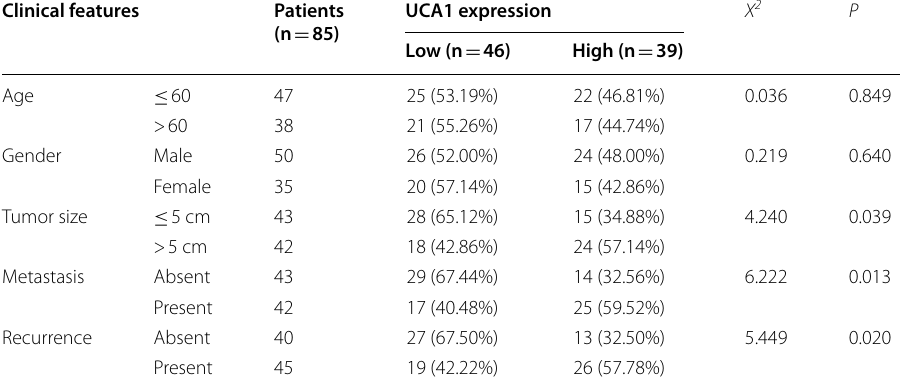
Table 1 Relationship between UCA1 expression and clinical features of gastric cancer Clinical features